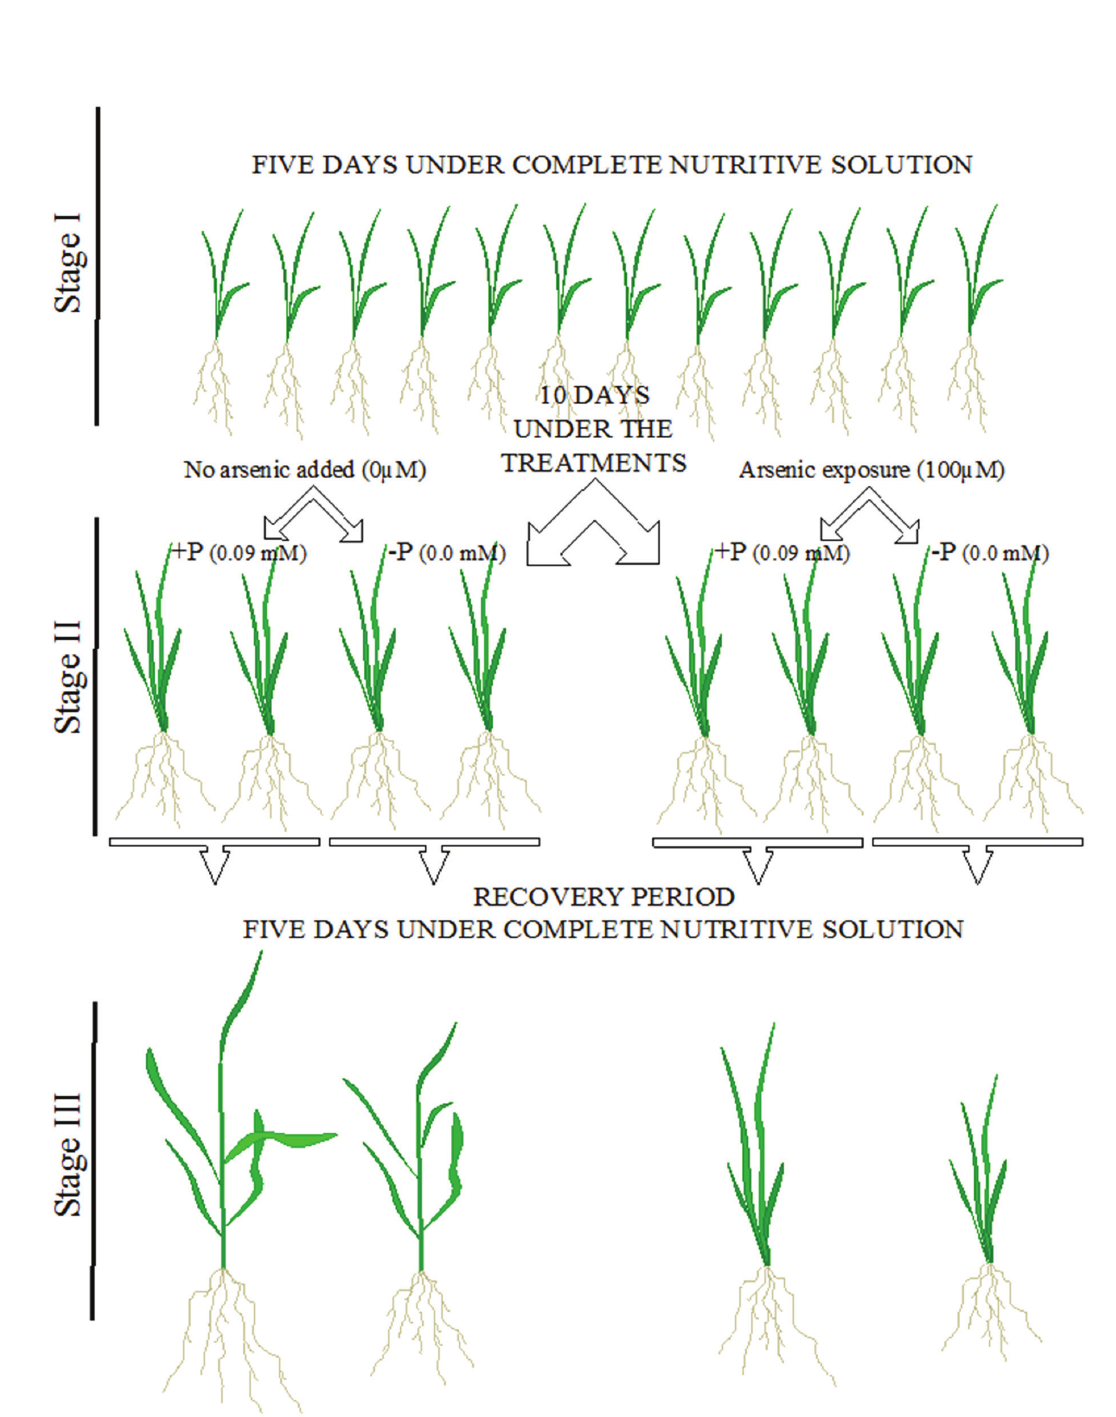
Figure 1 - Practical scheme of the experimental design used in this study (see the colors in the online